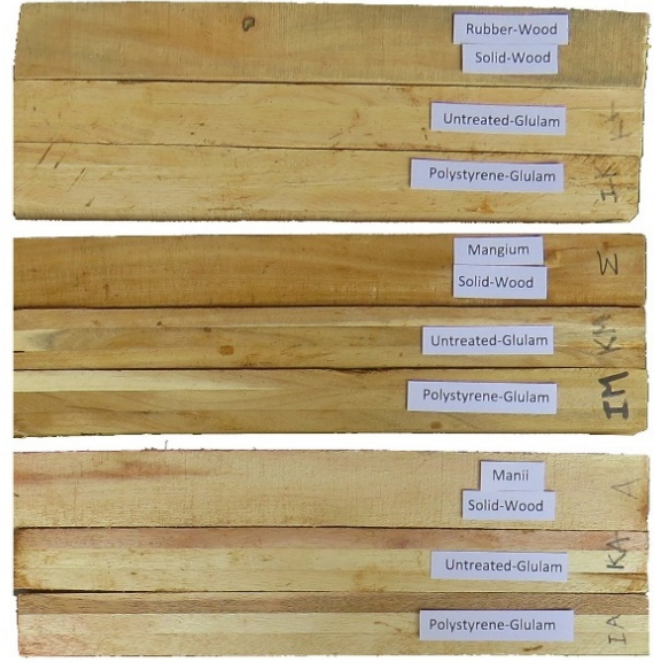
Figure 1. Test specimens of each wood species and wood product.